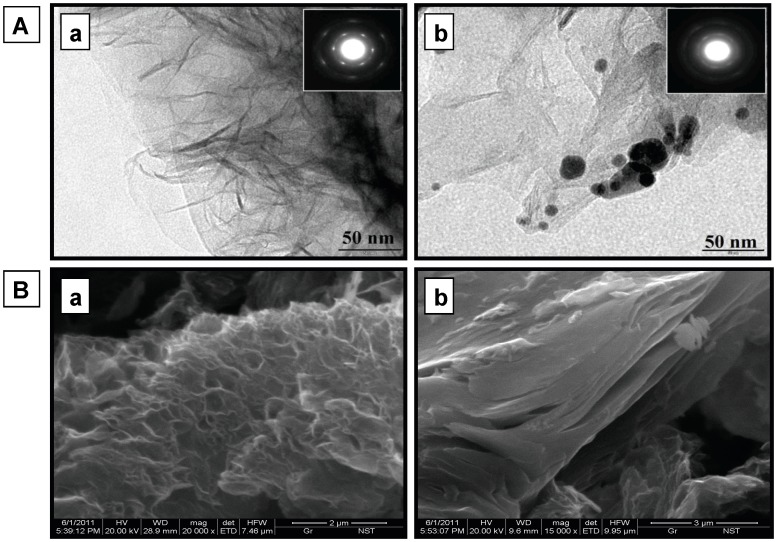
Micrographs of functionalized and immobilized graphene nano sheets.(A) Transmission Electron Micrograph (TEM) images of functionalized (a) and coupled (b) graphene showing fine transparent sheets with inset showing the characteristic Selected Area electron Diffraction pattern (SAD). Functionalized graphene sheets appear transparent whereas islands of immobilized enzyme can be seen in coupled graphene (B) Scanning Electron Micrograph (SEM) images of functionalized (a) and coupled (b) graphene.